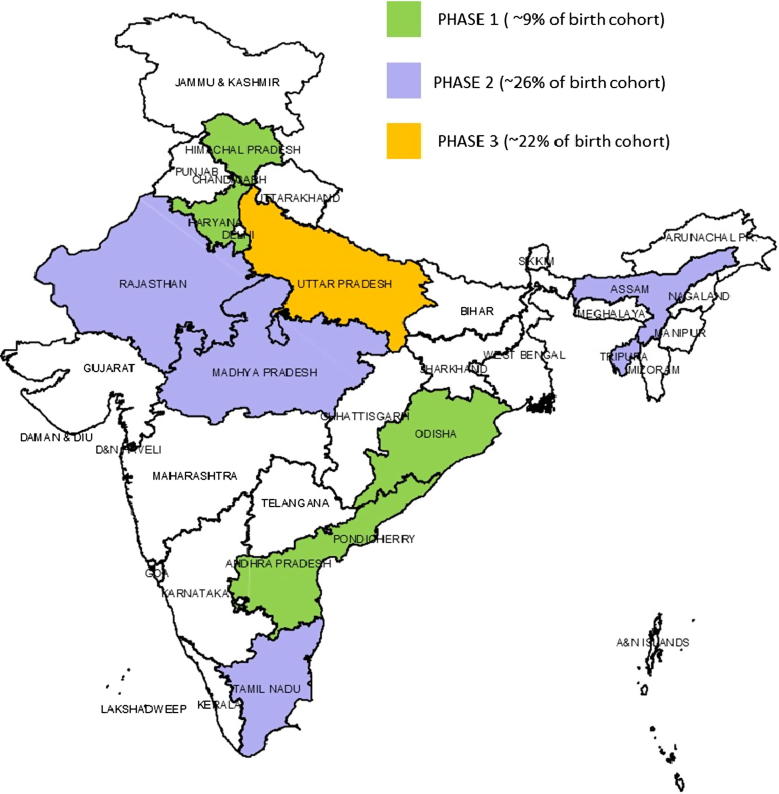
RVV introduction in India – Phase 1 and 2 states.